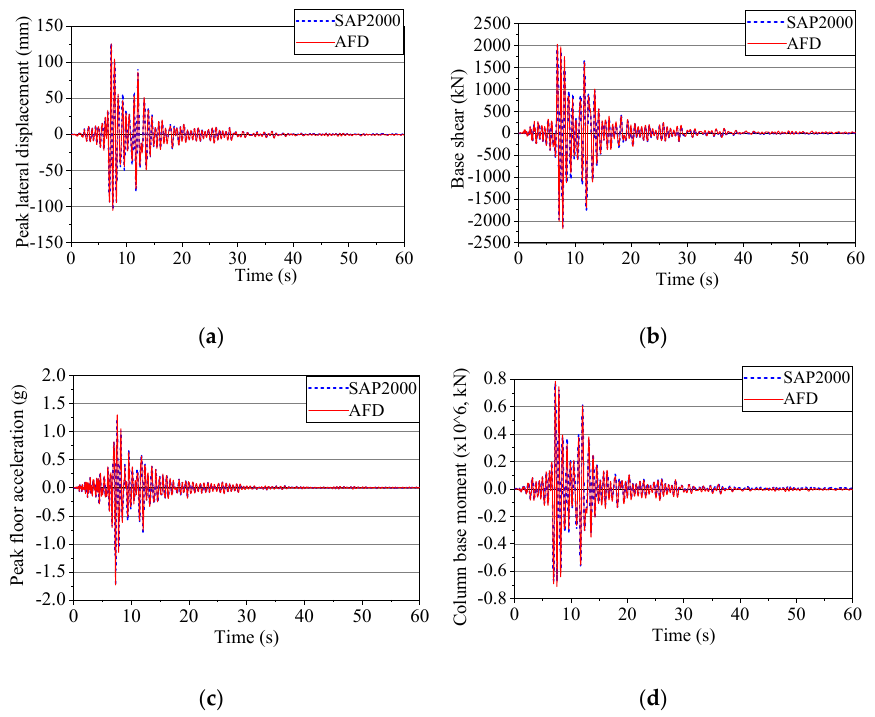
Figure 17. Responses of building when a device added to the first floor: ( a ) Peak lateral displacement; ( b ) Base shear; ( c ) Peak floor acceleration; ( d ) Base moment.